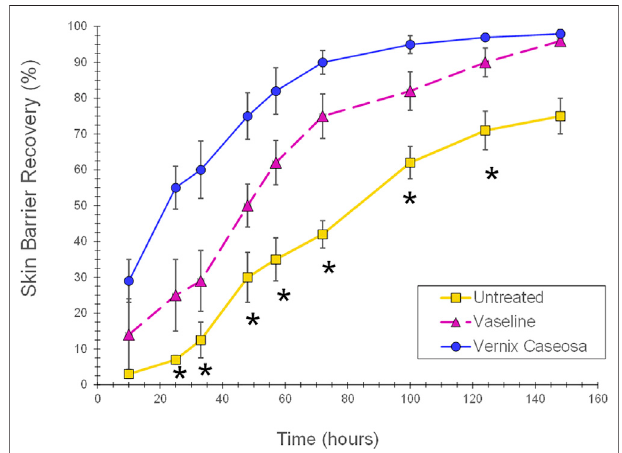
FIGURE 3 | Skin barrier repair following application of vernix or petrolatum versus untreated skin. Skin barrier damage was created by repeatedly tape stripping the SC in the hairless mouse model. The damaged skin sites were treated with 5 mg/cm 2 of vernix, 5 mg/cm 2 petrolatum, or left untreated as controls and barrier recovery monitored over time (one- way ANOVA, posthoc Bonferroni correction, and p < 0.05) (Oudshoorn et al., 2009b). Vernix treated skin demonstrated a signi fi cantly increased rate of SC barrier repair compared to untreated, damaged control skin. In the same study, treatment of damaged skin with petrolatum also signi fi cantly increased the SC barrier repair rate versus the untreated control, but the skin was more erythematous and thickened compared to the vernix treated skin ( p < 0.05). *Indicates signi fi cant difference for untreated skin versus vernix and petrolatum treated sites ( p <